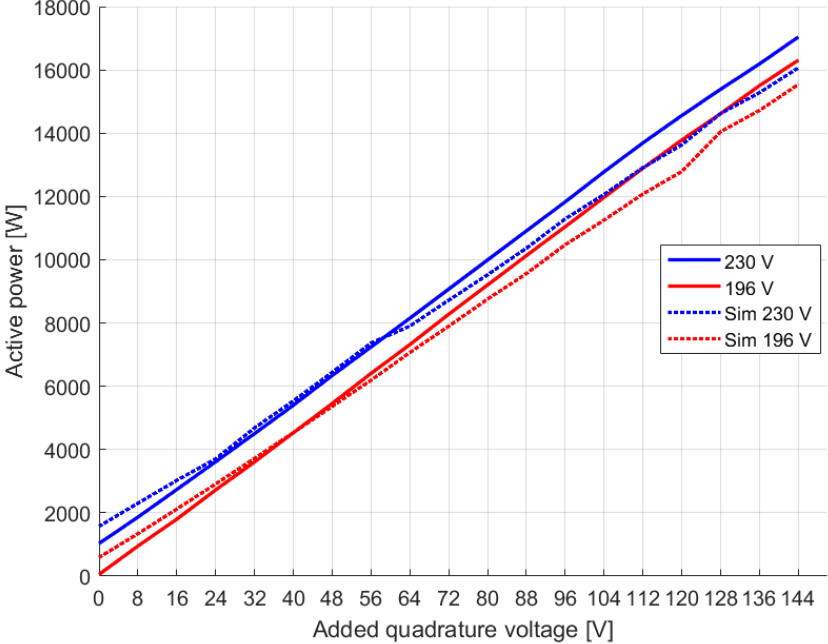
Figure 13. The active power transfer through the 22 sections transmission line for laboratory measurements (line) and simulations (dotted line).